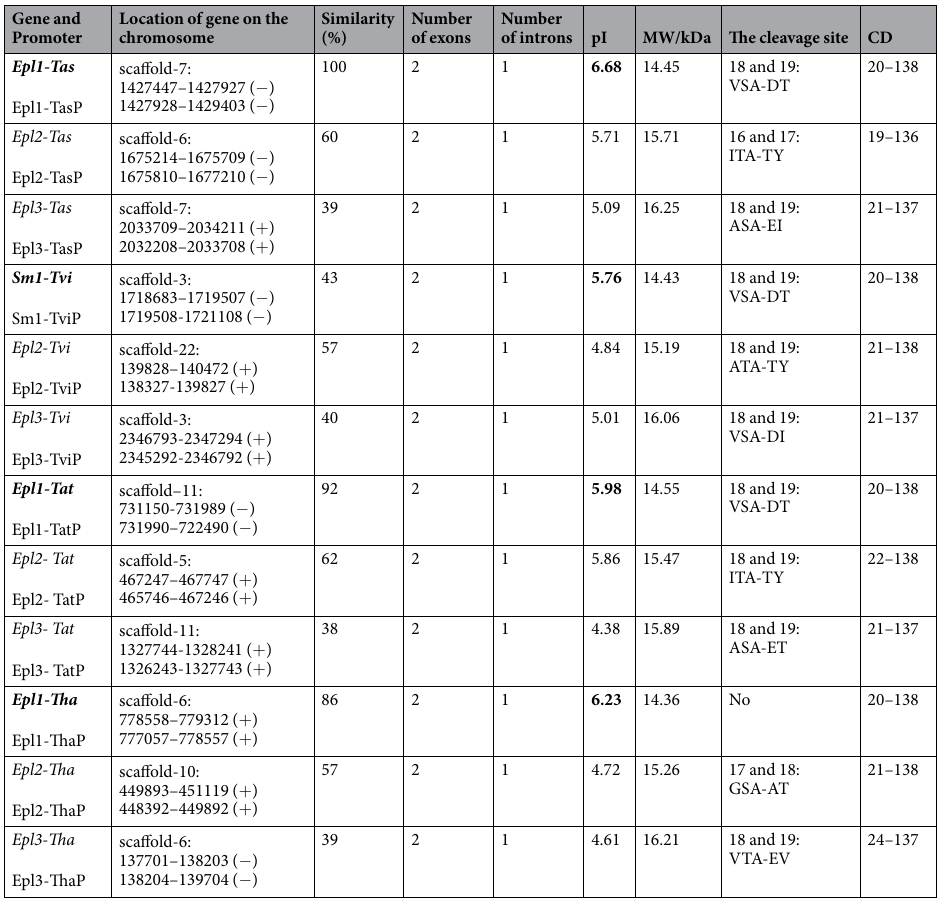
Table 1. Similarity sequences to Epl1-Tas and their promoters from four different Trichoderm a species genomes. Note: Epl: Eliciting plant response protein; Tas: T . asperellum ACCC30536; Tvi: T . virens Gv29–8; Tat: T . atroviride ATCC74058; Tha: T . harzianum CBS 226.95; -P: Promoter; AA: Number of amino acid; pI: Isoelectric point; MW: protein molecular weight; CD: Conserved domain; ( + ): Plus strand coding; ( − ): Minus strand